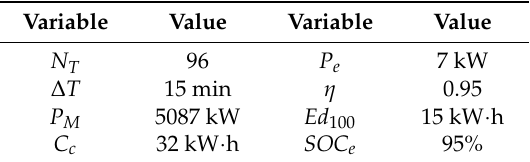
Table 1. Parameter values.